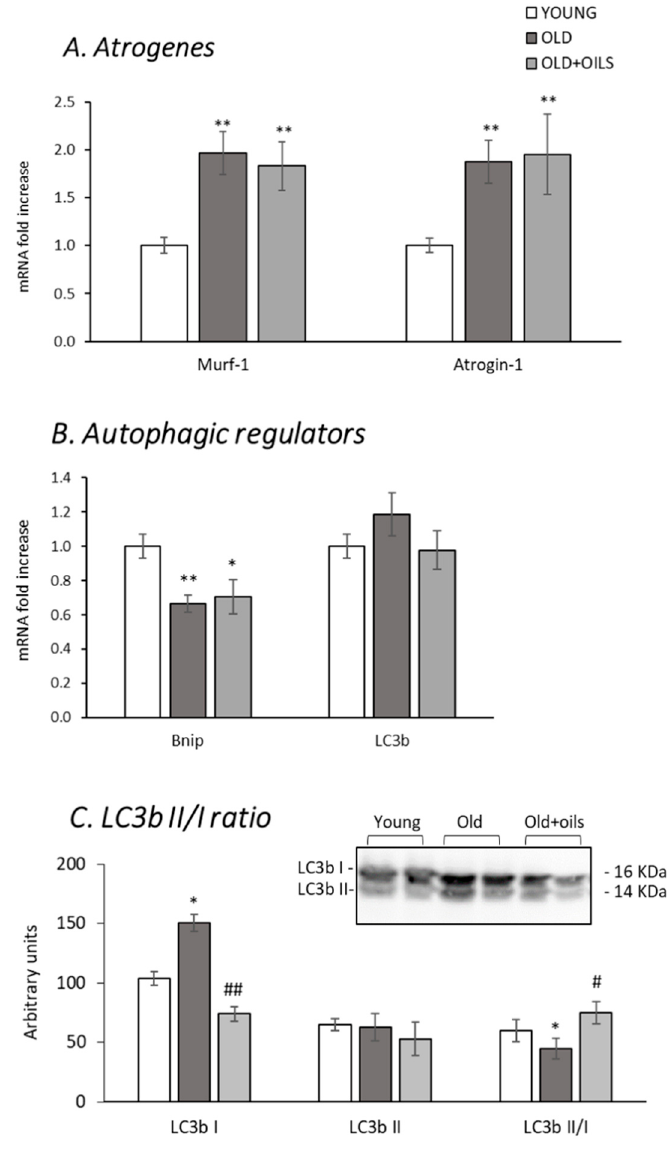
Figure 4. Oil mixture treatment did not prevent age-induced alterations in the expression of atrogenes and Bnip, although it did prevent a decrease in autophagy activity (ratio LC3b II/I) in skeletal muscle. Figures show gastrocnemius ( A ) muscle RING-finger protein-1 (MuRF1) and atrogin-1; ( B ) BCL2/adenovirus E1B 19 kDa interacting protein (Bnip) and 1A/1B-light chain 3 (LC3b) mRNA levels; ( C ) gastrocnemius protein levels and ratio between LC3b I and II of young rats ( n = 11), old rats ( n = 8) and old rats treated for 21 days with the oil mixture (OLD + OILS, n = 5). Values are represented as mean ± standard error of the mean (SEM). Statistics: ** p < 0.01 and * p < 0.05 vs. Young; ## p < 0.01 and # p < 0.05 vs. Old, by least-significant difference post hoc analysis after significant one-way analysis of variance (ANOVA).